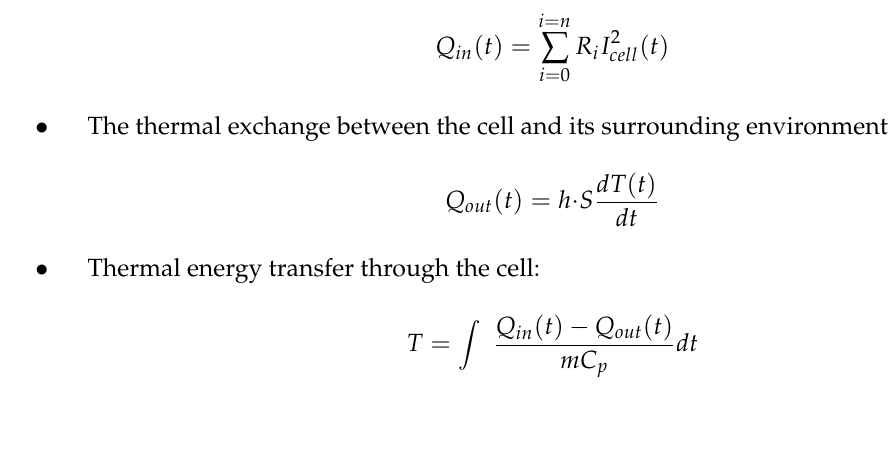
Figure 2. PE configuration 1: only PCS-1 is used. Figure 3. PE configuration 2: only PCS-2 is used.